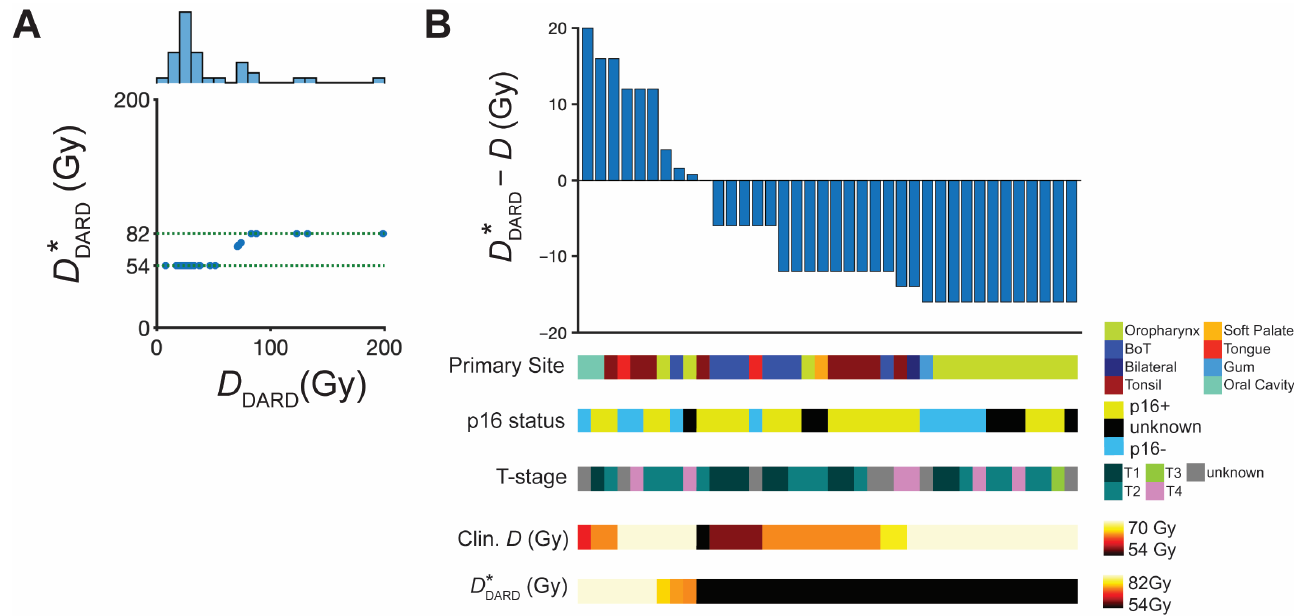
Figure 6. Dose adjustment to D DARD* and subsequent in silico trial results . ( A ) Scatter plot of D DARD* and D DARD limited to the moderate escalation/de-escalation range of (54,82) Gy for 38 patients. A histogram of the D DARD is projected above the scatterplot. ( B ) Waterfall plot of difference between D ∗ and the actual dose received in the clinic, where ∆ D > 0 DARD indicates dose escalation and ∆ D < 0 indicates dose de-escalation for the 38 patients that remained on the trial. Individual patient characteristics of interest (primary tumor site, p16 status, T-stage, cumulative dose received in the clinic, and D ∗ ) DARD are indicated for each patient below the waterfall